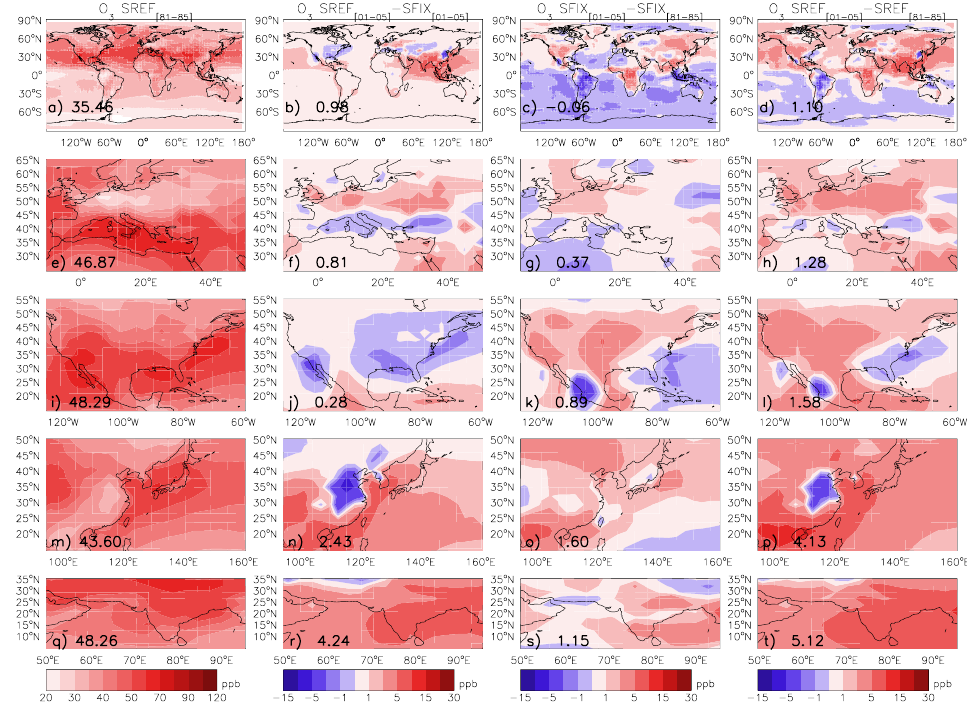
Fig. 5. Maps of surface O 3 concentrations and the changes due to anthropogenic emissions and natural variability. In the first column we show 5yr averages (1981–1985) of surface O 3 concentrations over the selected regions, Europe, North America, East Asia, and South Asia. In the second column (b) we show the effect of anthropogenic emission changes in the period 2001–2005 on surface O 3 concentrations, calculated as the difference between SREF and SFIX simulations. In the third column (c) the natural variability of O 3 concentrations is shown, which is due to natural emissions and meteorology in the simulated 25yr, calculated as the difference between the 5yr average periods (2001–2005) and (1981–1985) in the SFIX simulation. The combined effect of anthropogenic emissions and natural variability is shown in column (d) and it is expressed as the difference between the 5yr average period (2001–2005)–(1981–1985) in the SREF